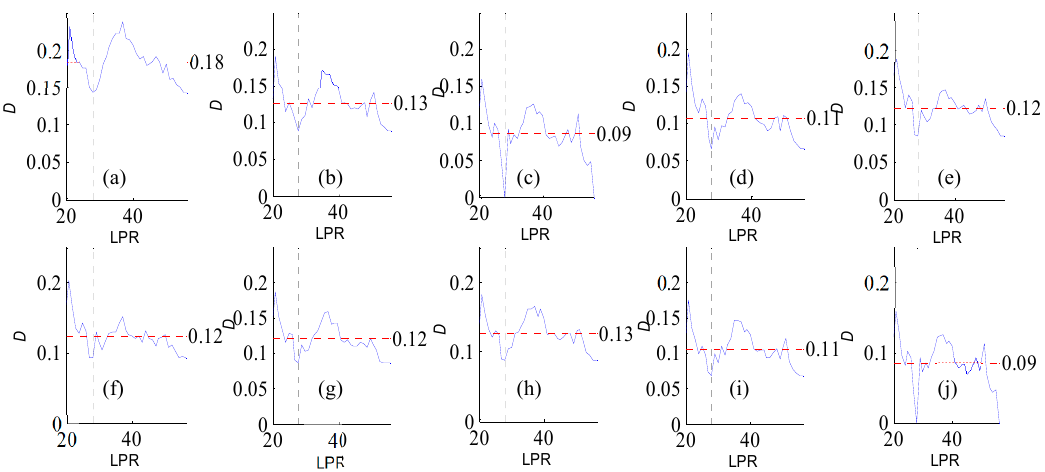
Figure A6. Variation of flow regime alteration degree (D) measured by the RVA with change in the length of post-impact flow time series (LPR) under a periodicity of 27 years. ( a ), ( b ), ( c ), ( d ), ( e ), ( f ), ( g ), ( h ), ( i ), and ( j ) correspond to pre-impact flow time series length = 19, 23, 27, 31, 35, 39, 42, 46, 50, and 54 years, respectively. The abscissa value for the vertical dotted line is 27. The ordinate value for the horizontal dotted line is the mean degree of flow regime alteration in each subfigure.